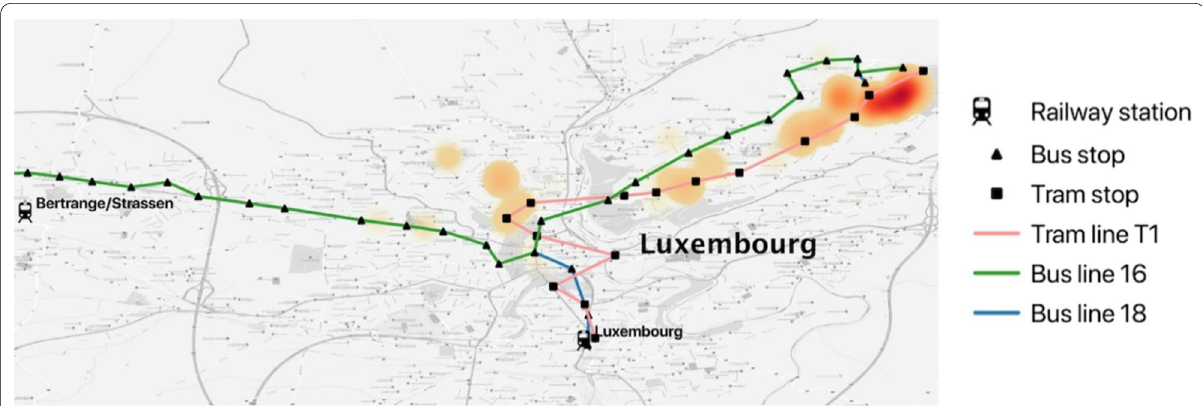
Fig. 5 Example of possible public transport options to commute from Arlon to Luxembourg City (the hot spots are Kussbus ride request